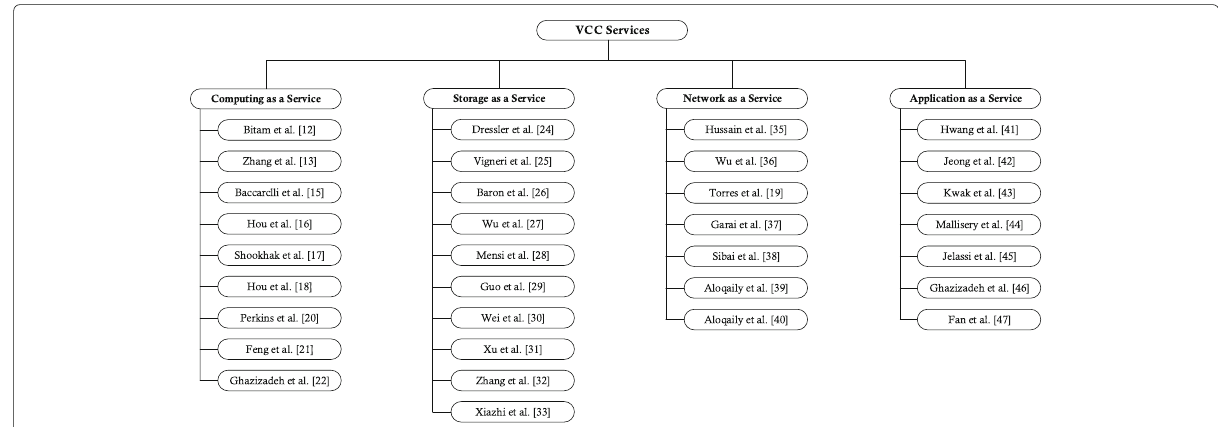
Fig. 2 Taxonomy of Vehicular Cloud Computing Services. Taxonomy representing all discussed Vehicular Cloud Computing